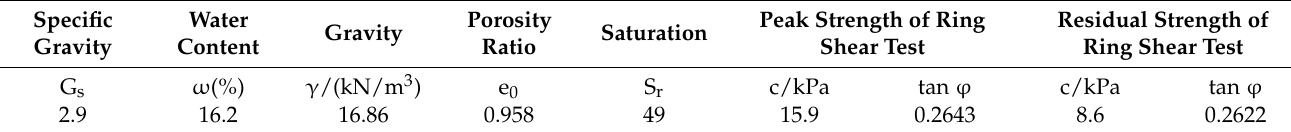
Table 2. Physical and mechanical property parameters of tailing sand.